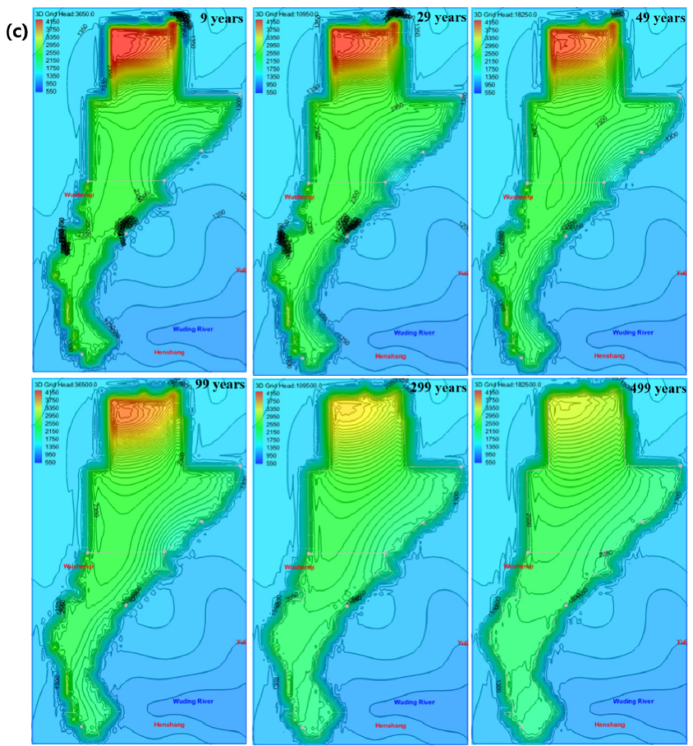
Figure 8. ( a ) The simulated original hydrodynamic field of LFm by the topography-driven regional groundwater flow method. Hujierte and Nalinhe coal mining regions were selected as the large-scale application sites for mine water injection. Each injection well interval was set 3 km × 3 km and the dotted rectangle was the most sensitive zone of water heading. ( b ) Water-table fluctuation zone of water injection activity of the time step at 1 month, 6 months, 1 year, 2 years, ( c ) 9 years, 29 years, 49 years, 99 years, 299 years and 499 years. It was the magnified zone of the dotted rectangle.